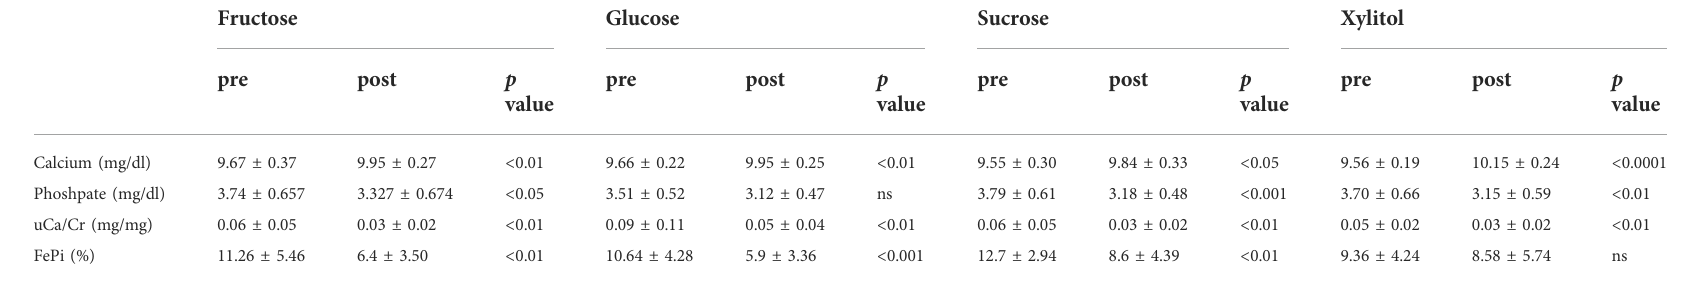
TABLE 9 Changes in calcium and phosphate serum levels and urine excretions.